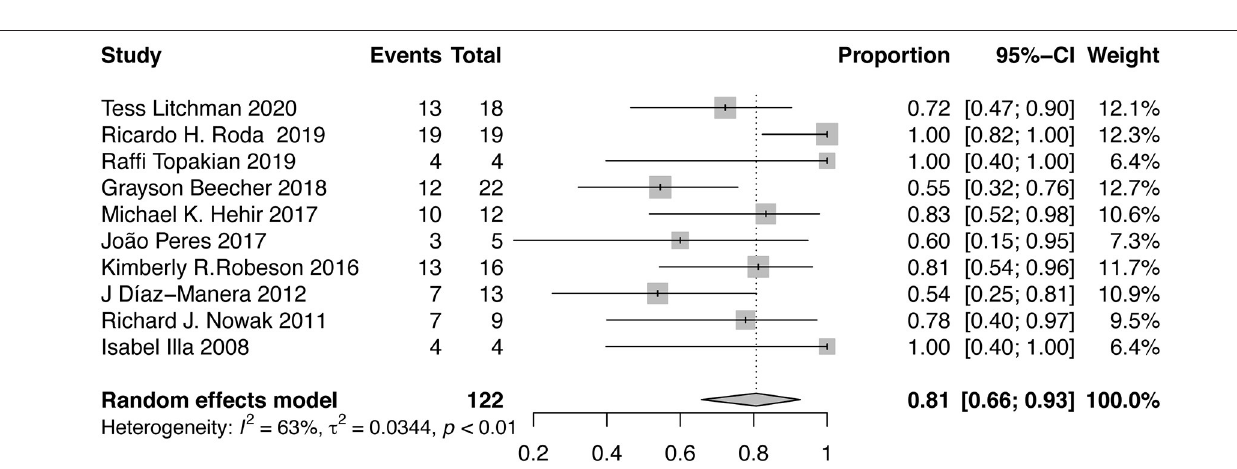
Frontiers in Neurology | www.frontiersin.org